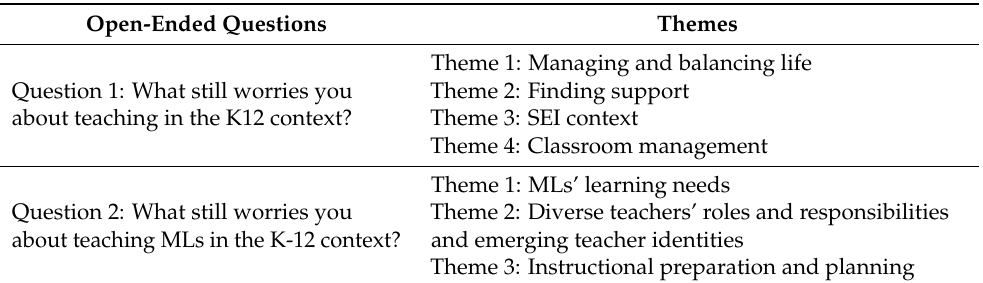
Table 2. Themes from open-ended Questions 1 and